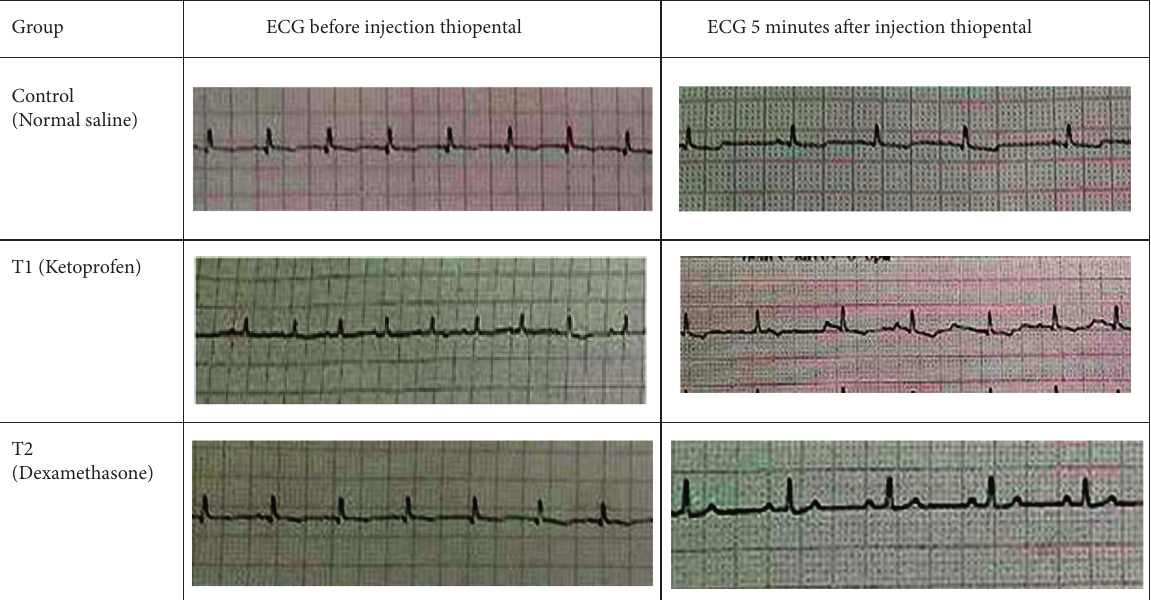
Figure 2: A typical sample of electrocardiogram (ECG) taken from animals in control and treatment groups before and 5 minutes after thiopental injection. Table 2: Changes in QT interval in the electrocardiogram in different groups. ECG parameter